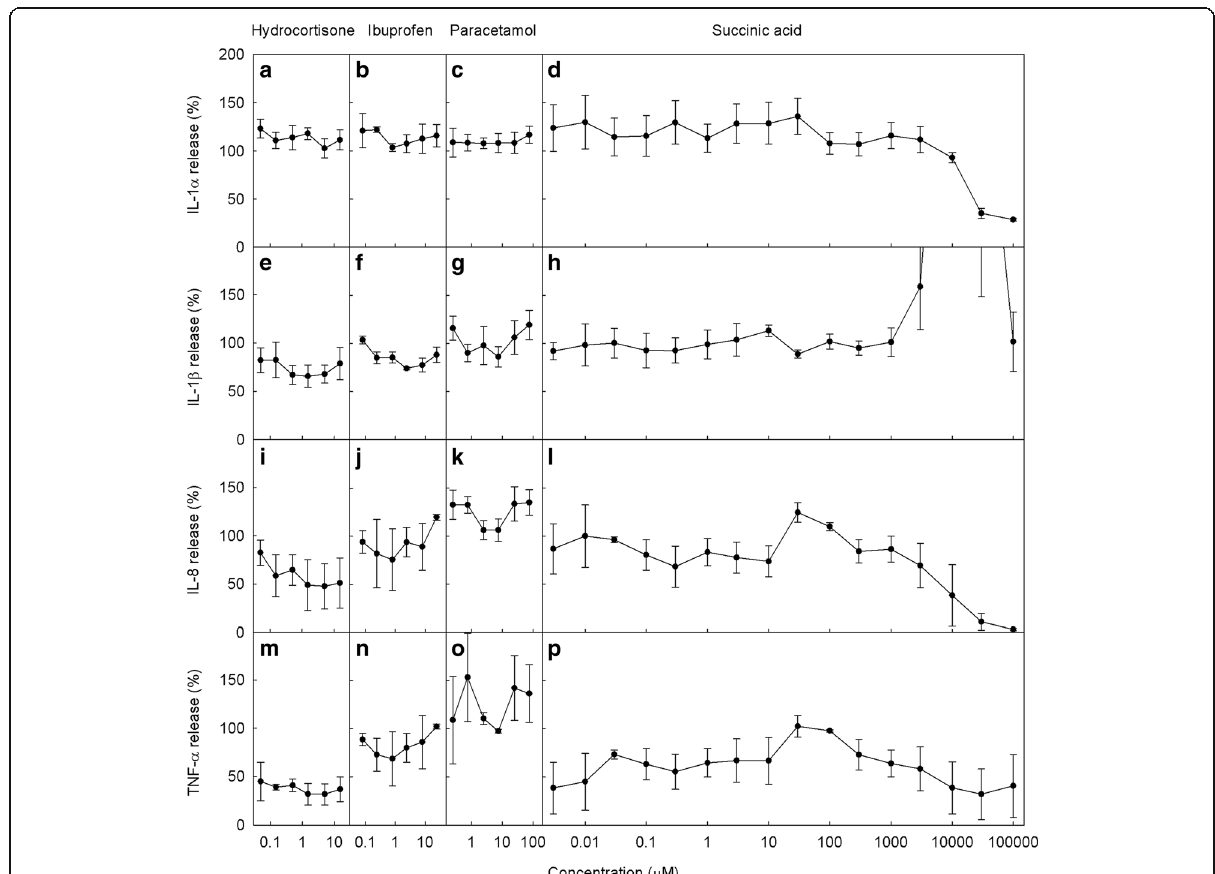
Fig. 4 The effects of succinic acid and anti-inflammatory drugs on inflammatory cytokine production. THP-1 human macrophage cells were stimulated with LPS in the presence of the indicated concentrations of each drug and the production of various inflammatory cytokines after 4 h of stimulation were measured by ELISA. Results are presented on a scale that is normalised against results for LPS-only cells. Culture supernatant concentrations of IL-1 α ( a - d ), IL-1 β ( e - h ), IL-8 ( i - l ) and TNF α ( m - p ) in the presence of hydrocortisone ( a , e , I , m ), ibuprofen ( b , f , j , n ), paracetamol